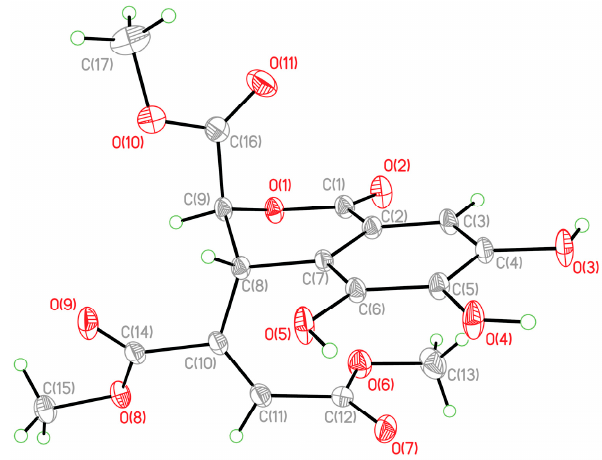
Figure 4 . X-ray ORTEP drawing of 2 . Figure 4. X-ray ORTEP drawing of 2